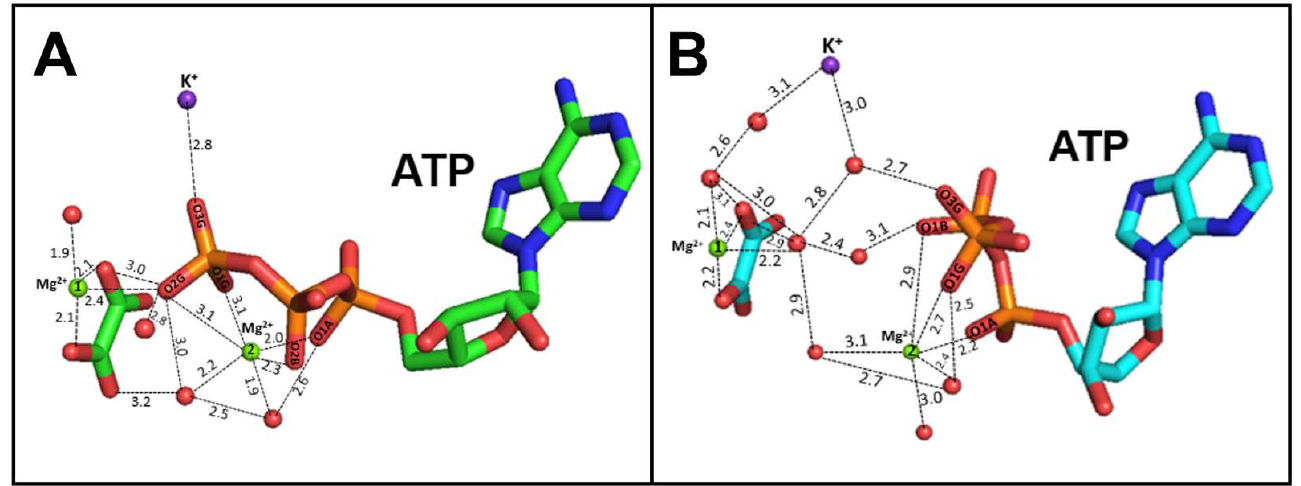
Figure 10. Differential coordination of Mg-ATP in the active site of a K + -dependent PK (WT-RMPK) ( A ) and in a K + -independent PK ( Mtb PK) ( B ). Panel A and Panel B show the coordination of oxalate, Mg 2+ , Mg-ATP, and K + in the active sites of RMPK (PDB 1A49 subunit A; green) and of Mtb PK (PDB 5WS9 subunit A; cyan), respectively. No residues of the enzymes are shown.